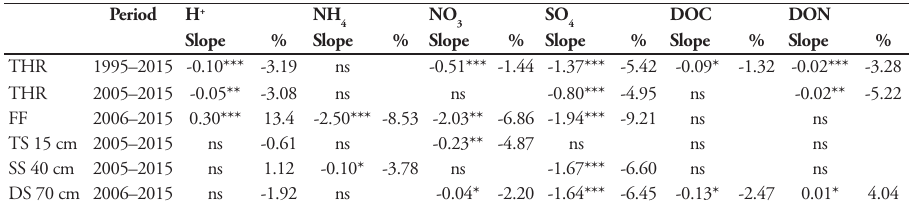
Table 4. Mann – Kendall trends for chemical species concentration analyzed in throughfall deposition (THR), forest floor leachate (FF), topsoil (TS = soil solution at 15 cm depth), subsoil (SS = soil solution at 40 cm depth) and deep soil (DS = soil solution at 70 cm depth). Significance of Sen’s slope: *p ≤ 0.05; **p ≤ 0.01; ***p ≤ 0.001; ns: not